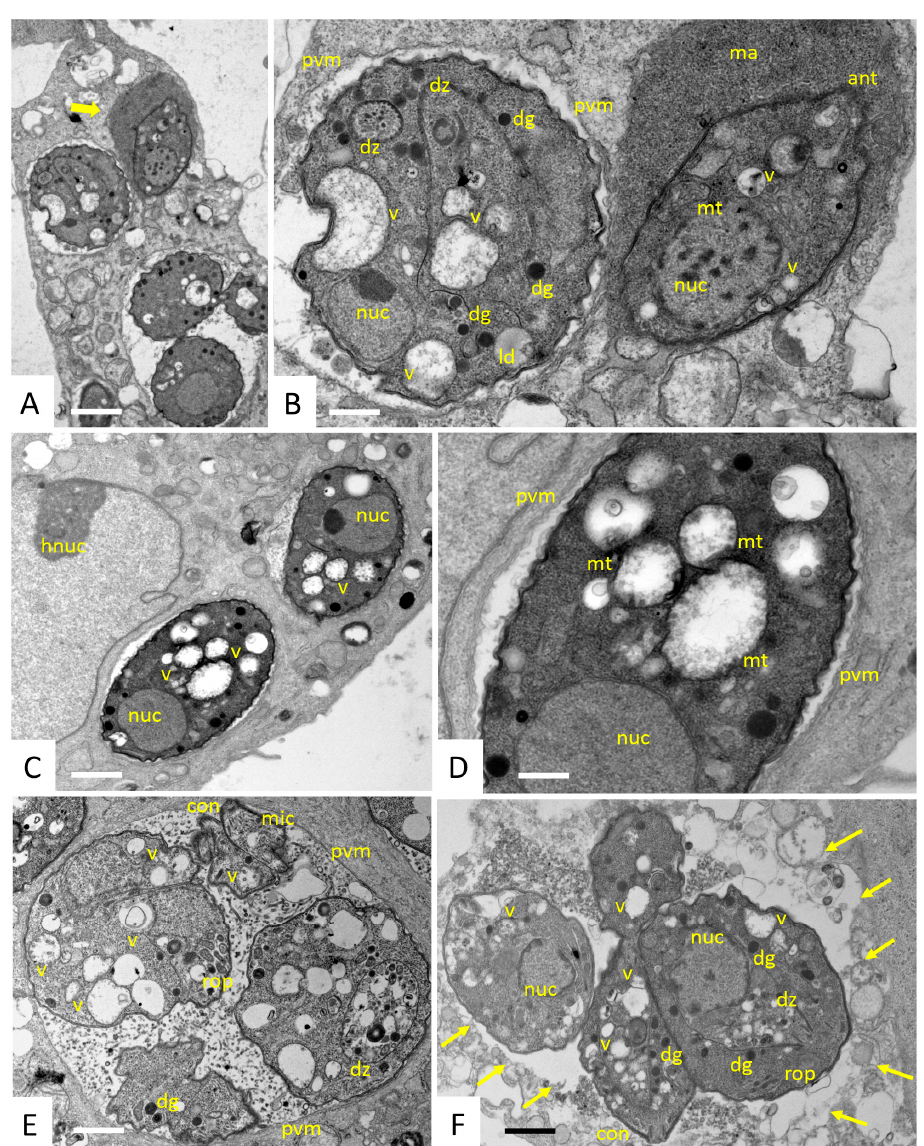
Figure 3. Ultrastructure of T. gondii tachyzoites grown in HFF exposed to peptide 6027 during 6 h ( A – D ), 24 h ( E ) and 48 h ( F ). ( A , C ) are lower-magnification views, while ( B , D ) show more detailed views at higher magnification. The bold arrow in A points to a tachyzoite located in a vacuole that is filled with an electron-dense matrix (ma), and the thin arrows in ( F ) indicate the lack of a defined parasitophorous vacuole membrane (pvm) after 48 h of treatment ( F ); ant = anterior end; dz = emerging daughter zoites; dg = dense granules; hnuc = host nucleus; rop = rhoptries; mic = micronemes; nuc = nucleus; con = conoid; v = vacuolization; mt = mitochondrial residues; ld = lipid droplets. Bars in ( A ) = 1.1 µm; ( B ) = 0.35 µm; ( C )= 0.75 µm; ( D ) = 0.28 µm; ( E , F ) = 0.75 µm.